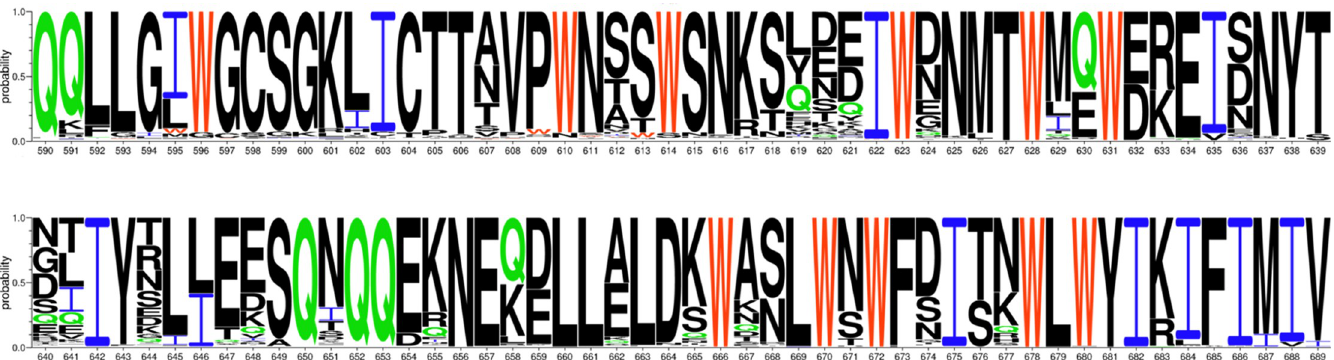
Fig 5. Trp-rich sequence motifs in the gp41 region of Env. The figure was generated using the AnalyzeAlign database of the Los Alamos National Laboratory (http:// www.hiv.lanl.gov/) based on the curated alignment of 6636 sequences. Trp residues are shown in red, Gln residues in green and Ile residues in blue. Abundances of selected residues are shown in S3